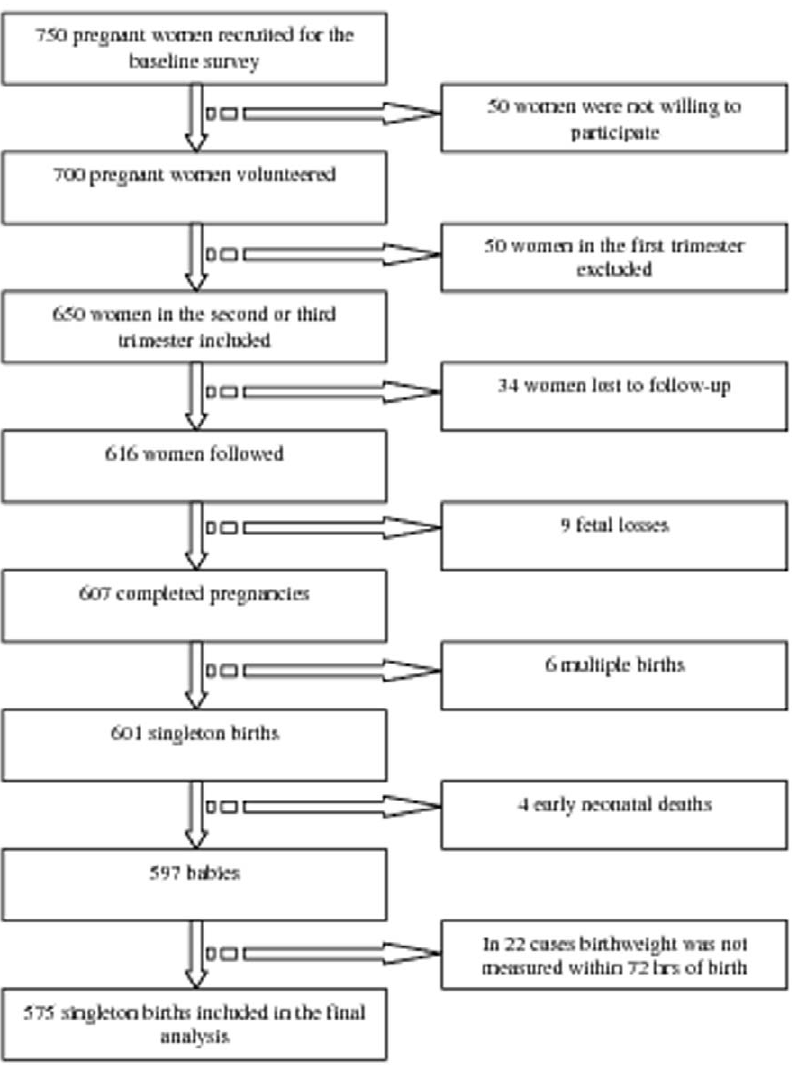
Figure 1. Flowchart of the cohort from exposure assessment to outcome ascertainment.